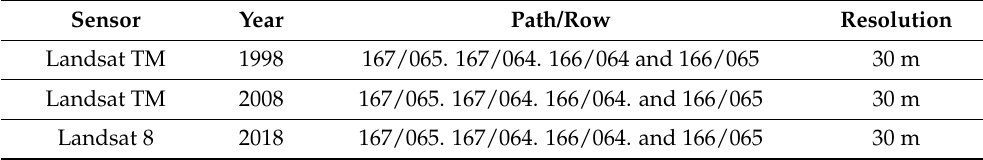
Table A1. Landsat images used to map land-cover classes of the Wami Mbiki–Saadani wildlife corridor in 1998, 2008, and 2018. Source: Earth Explorer (https://earthexplorer.usgs.gov) web plat form accessed on 15 January 2020. All images have <10% cloud